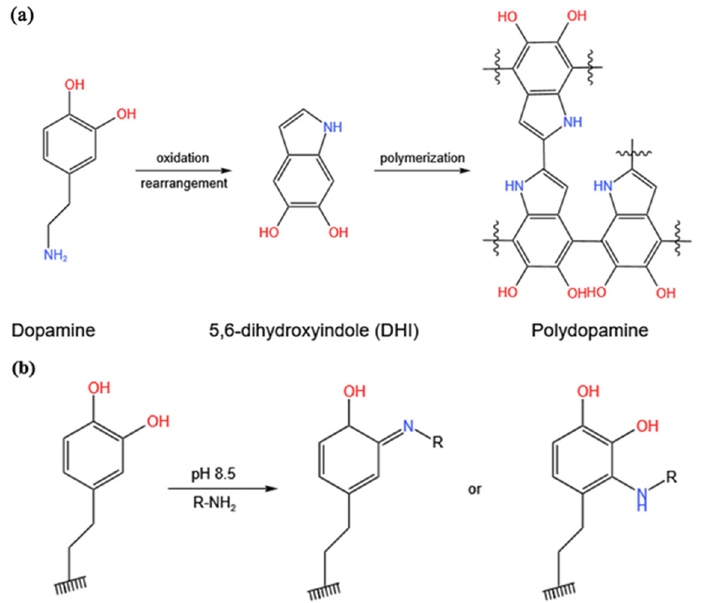
Figure 1. ( a ) Polymerization of dopamine; ( b ) Chemical modification of polydopamine via a Schiff base reaction or Michael addition reaction.